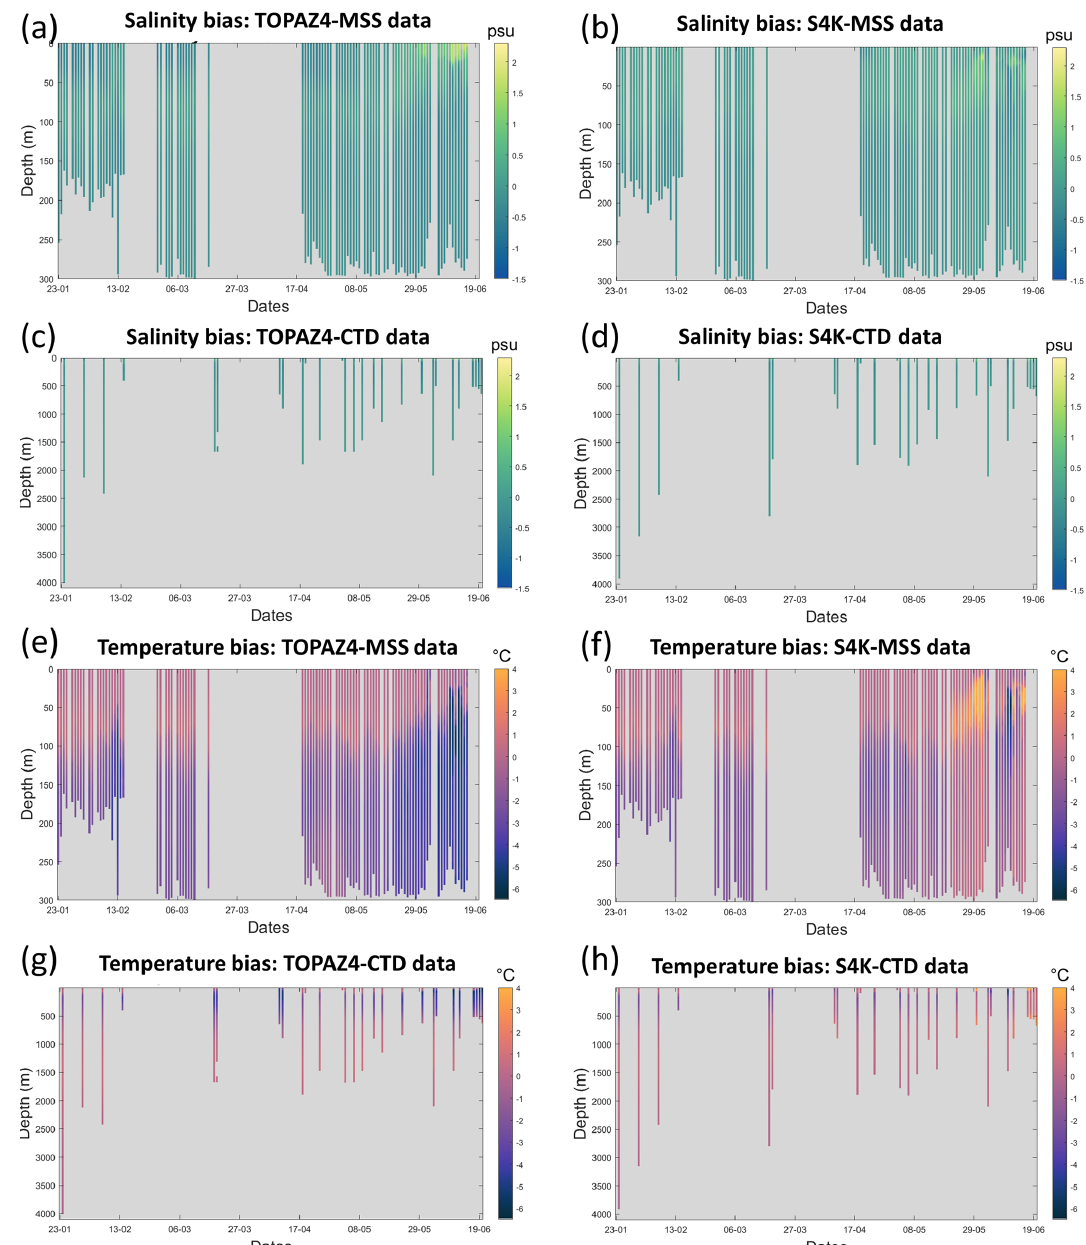
Figure 5. TOPAZ4 (a, c, e, g) and S4K (b, d, f, h) model salinity (upper four panels) and temperature (lower four panels) biases, as a function of time and depth, from profiles obtained during the N-ICE2015 expedition (Granskog et al., 2018). Panels (a) , (b) , (e) and (f) show biases for the upper 300m, based on data from ocean microstructure profiles (MSS) (Meyer et al., 2016). Panels (c) , (d) , (g) and (h) show biases for the whole water column, based on CTD profiles (Dodd et al., 2016) (see Fig. 1, Table 5 and text).